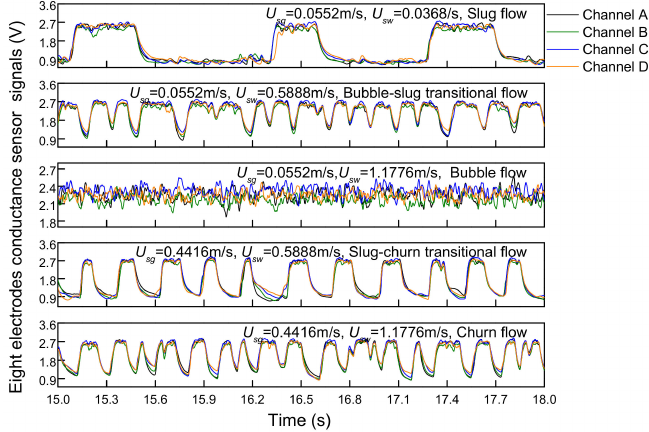
Figure 8. The responses of an eight-electrode rotating electric field conductance sensor.